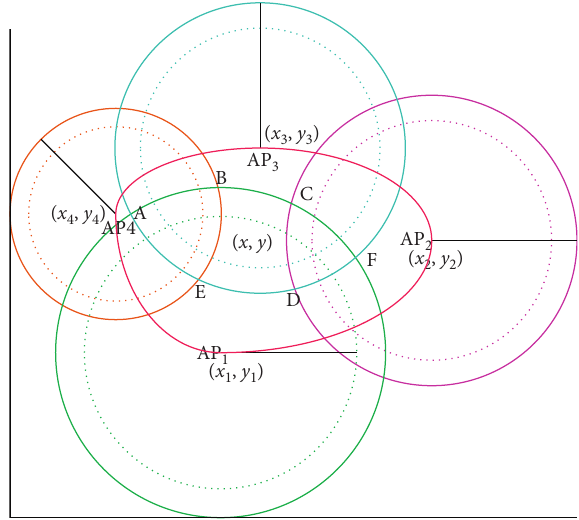
Figure 1: Principle diagram of three-sided positioning